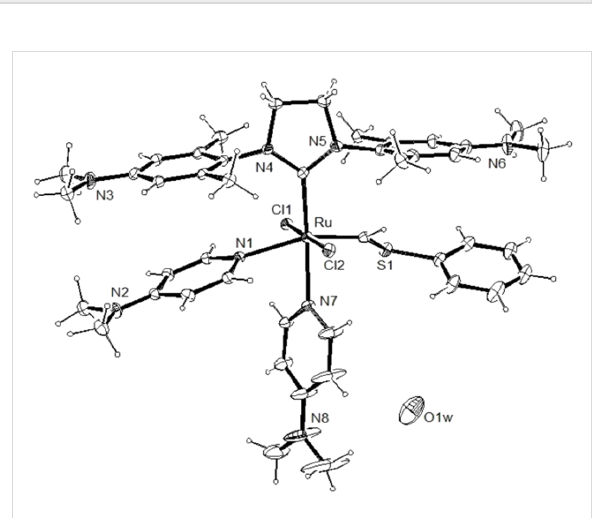
Scheme 2: Synthesis of hexacoordinate, pH-responsive complexes 11 and 12 .